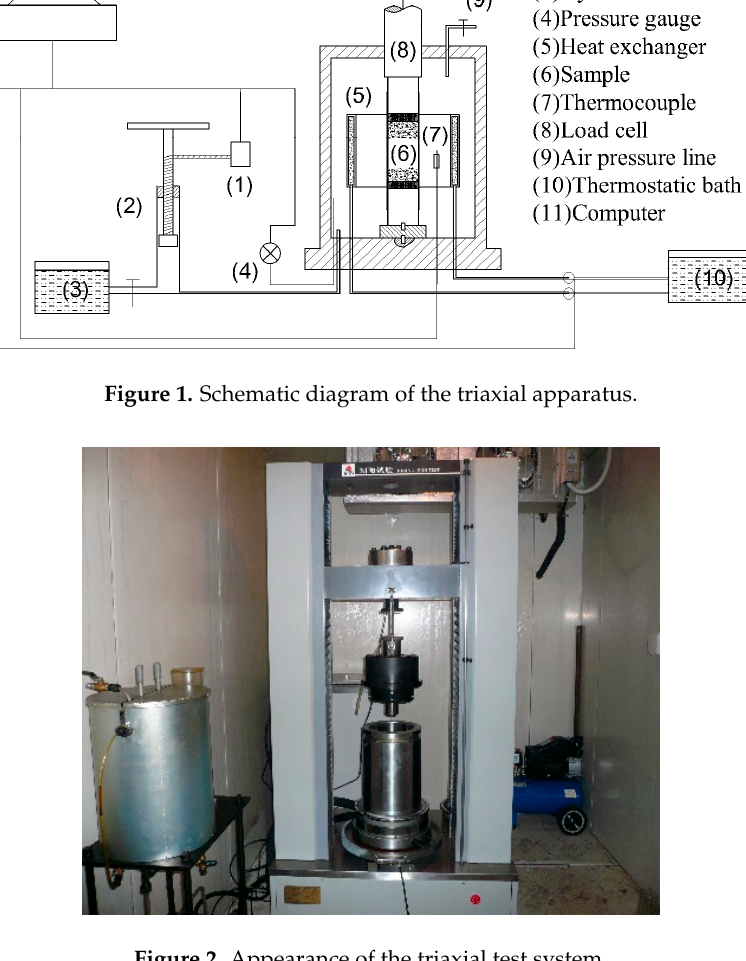
Figure 2. Appearance of the triaxial test system.